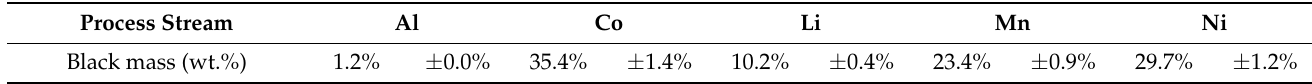
Table 6. The average metal content and standard error of LIB black mass powder. Process Stream Al Co Li Mn Ni Black mass (wt.%)